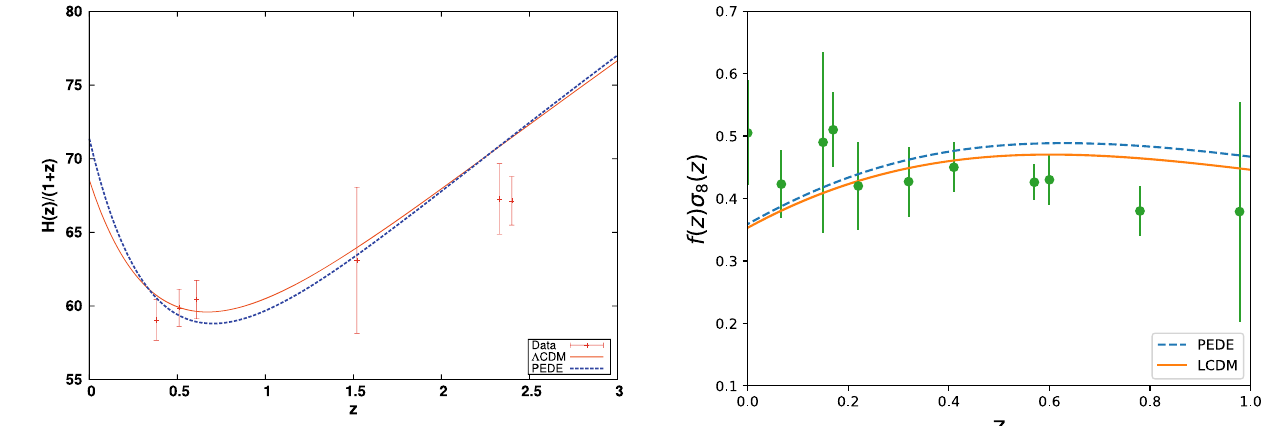
Fig. 3 The redshift evolution of f σ 8 for PEDE and (cid:2) CDM and the observational data points. We set the free parameters upon their best fit values from the last columns of Tables 2 and